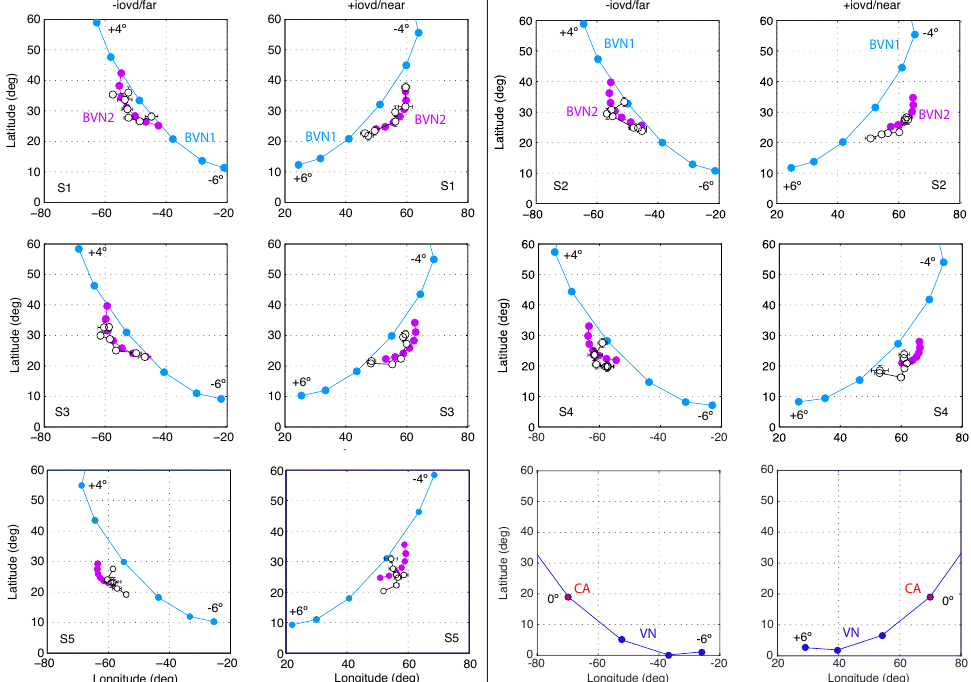
Figure 9. Motion directions in Exp. 2. In two columns pairs of graphs are shown for Observer S1 to S5 with − IOVD/far on the left +IOVD/near on the right. In each graph latitude is plotted against longitude angles. Circles connected by a line indicate motion directions for the seven line stimuli slanted in depth from oblique with orientation difference − 6 ◦ to + 6 ◦ in steps of 2 ◦ . Black open circles represent observed longitude and latitude angles, averaged across repeated trials. Horizontal and vertical error bars denote ± 1 SEM. Light blue and light purple circles denote angular estimates of the best-fitting BVN1 and BVN2 model, respectively. The last pair of graphs illustrates the geometric predictions of VN (blue circles) and the CA (red